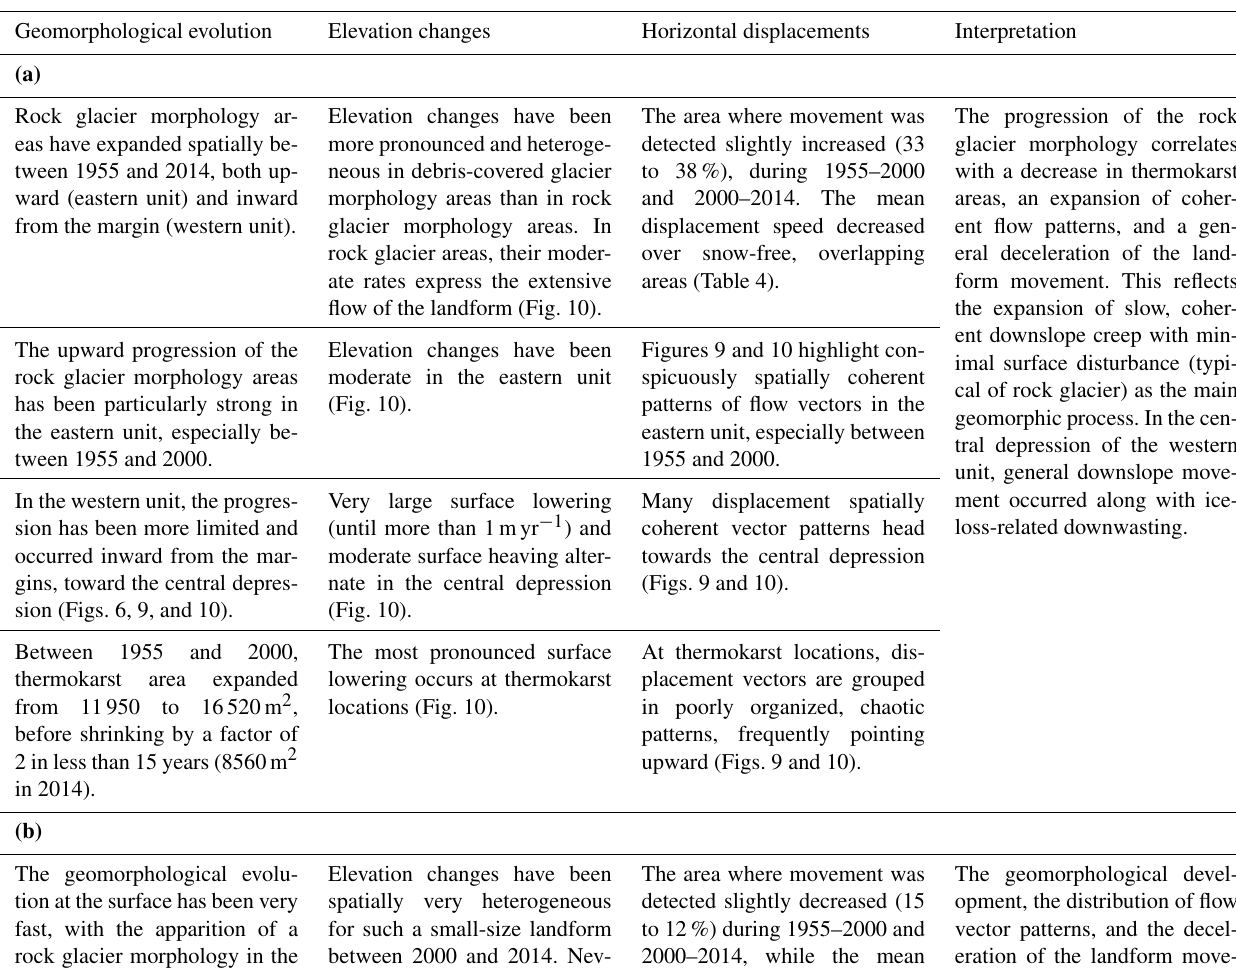
Table 5. (a) Summary of corresponding geomorphological evolution, elevation changes, horizontal displacements, and associated interpre- tations at Navarro for historical (1955–2000) and contemporary (2000–2014) periods. (b) Summary of corresponding geomorphological evolution, elevation changes, horizontal displacements, and associated interpretations at Presenteseracae for historical (1955–2000) and